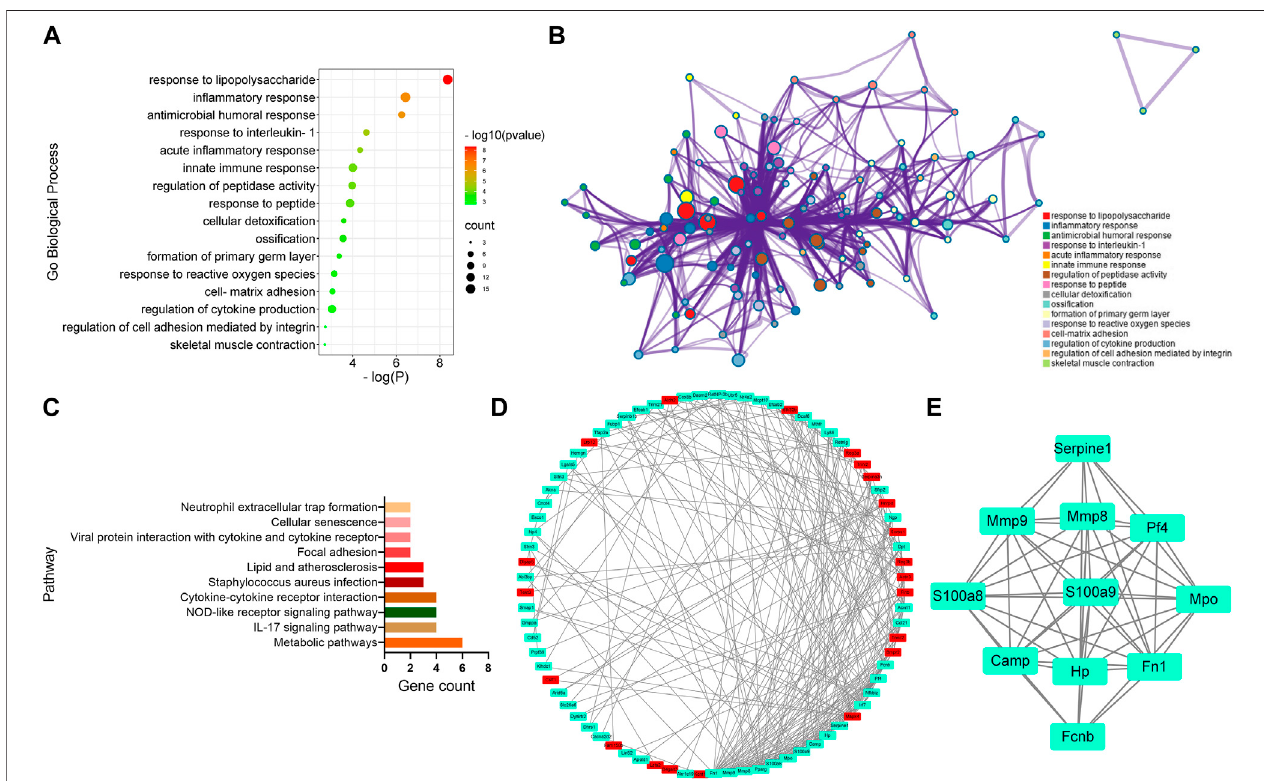
FIGURE 3 | GO, KEGG, and protein – protein interaction (PPI) network analysis of DEGs between the CFA group and Sham group. (A,B) GO Biological Process enrichment of DEGs. (C) KEGG pathway enrichment of DEGs. (D) PPI network of DEGs. (E) A cluster was obtained by MCODE in Cytoscape.